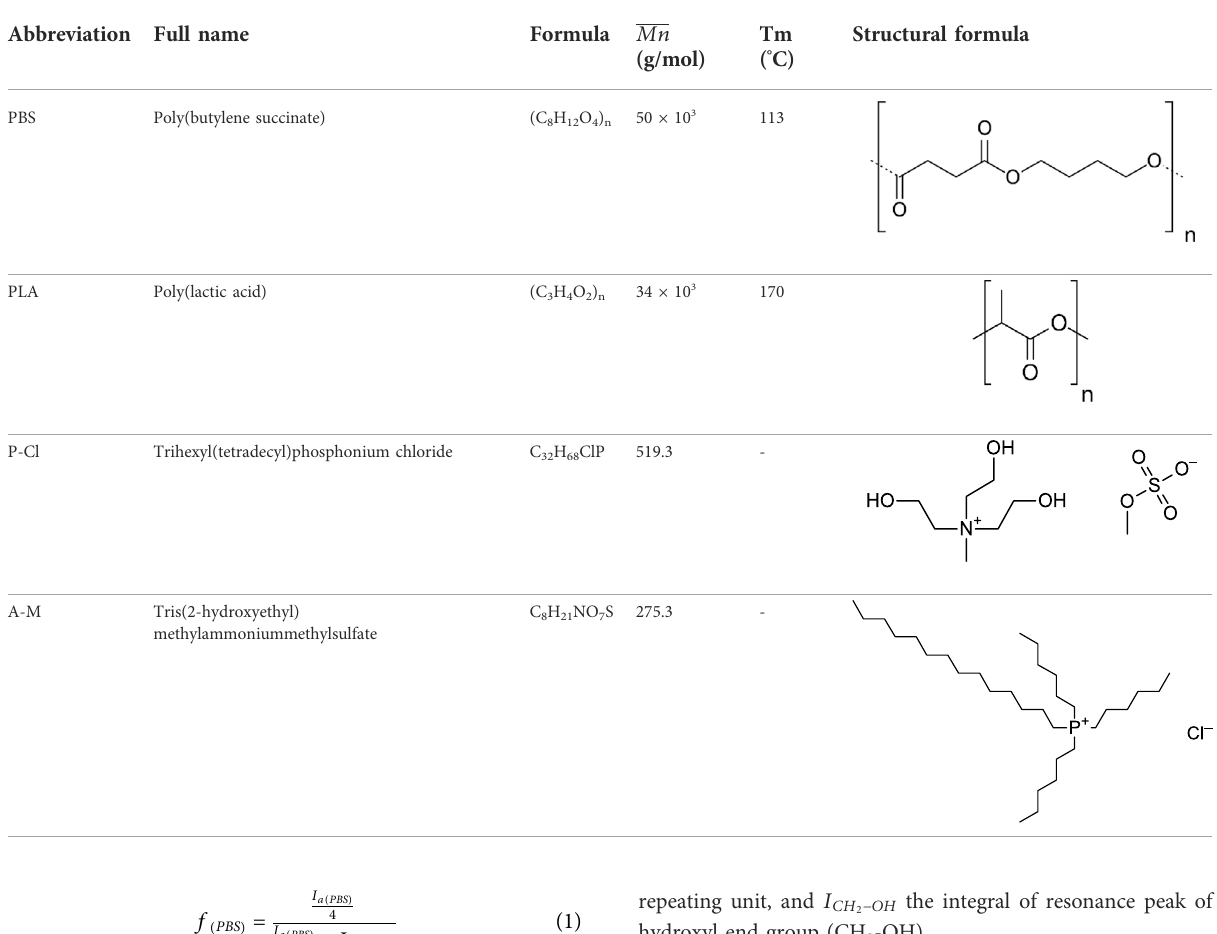
TABLE 1 Formula of studied polymers and Ionic